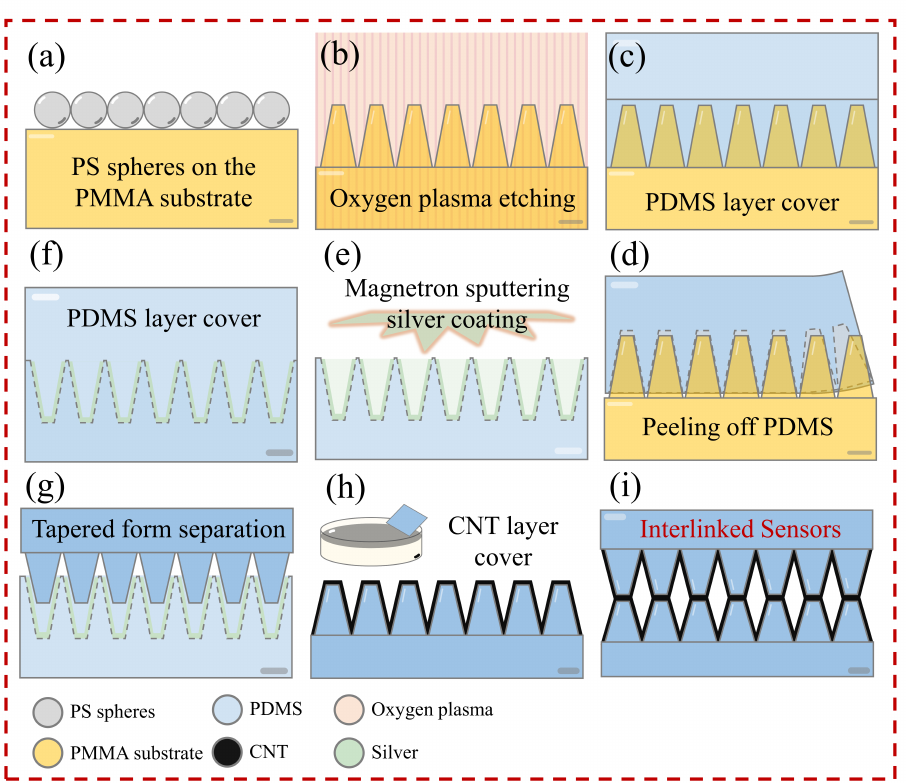
Figure 1. The scheme of fabricating the interlinked resistive sensors: ( a ) self-assembly of PS mi- crospheres on PMMA substrate; ( b ) microcone structure was prepared by oxygen plasma etching; ( c ) PDMS was coated on the microcone structure; ( d ) PDMS layer on the microcone film was stripped; ( e ) the silver layer was deposited on the PDMS microporous template by magnetron sputtering; ( f ) PDMS was coated on the microporous template; ( g ) PDMS film with tapered structure was stripped; ( h ) CNTs were coated on the microcone PDMS film; ( i ) interlock sensor was combined by two microcone